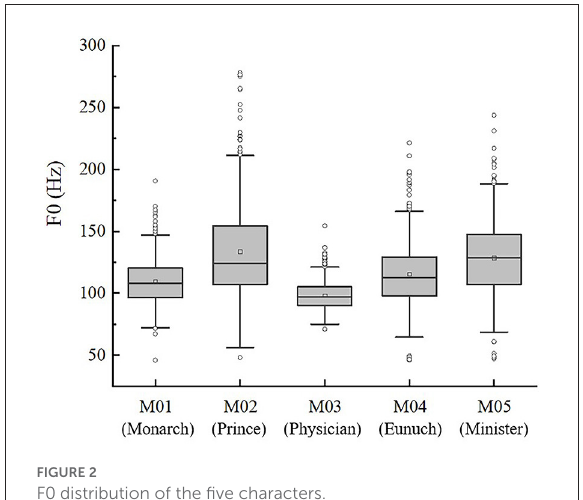
FIGURE2 F0 distribution of the five characters.